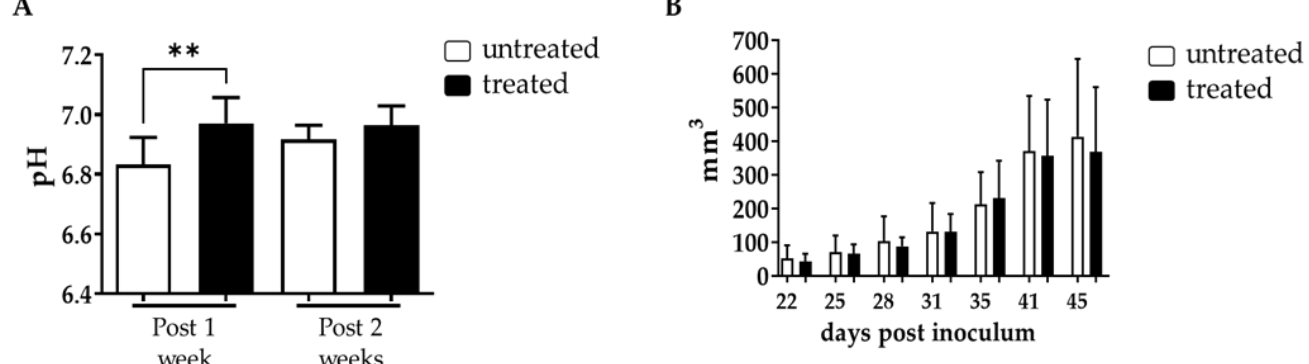
Figure 4. Chronic effect of Esomeprazole on tumor extracellular pH and tumor growth. Measured extracellular tumor pH values ( A ) following long-term Esomeprazole oral administration in the DU145 subcutaneous tumor murine model between untreated ( n = 8) and treated ( n = 8) groups after one week (28 days) and two weeks (35 days) of treatment (white and black bars, respectively, ** p value < 0.01). Tumor growing curves obtained from caliper measurements ( B ). Representative tumor extracellular pH maps for control and treated mice showed a marked reduction in tumor extracellular acidosis for Esomeprazole-treated mice after one week of treatment, in comparison to control mice, whereas extracellular tumor pH values were comparable after two weeks of treatment (Figure 5).